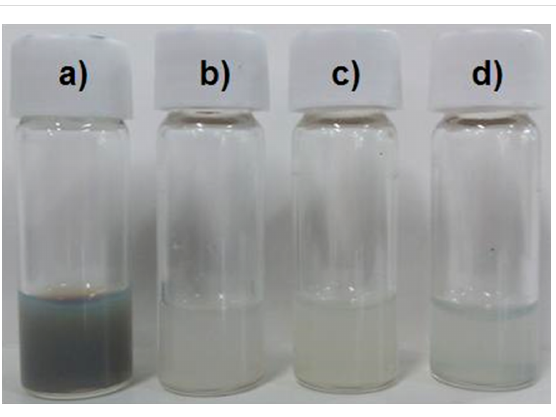
Figure 5: Picture of the dispersions of a) ND50-PG (20 mg/mL), b) ND-PG-Arg 8 , c) ND-PG-Lys 8 and d) ND-PG-His 8 (b–d, 1.0 mg/mL) in water.